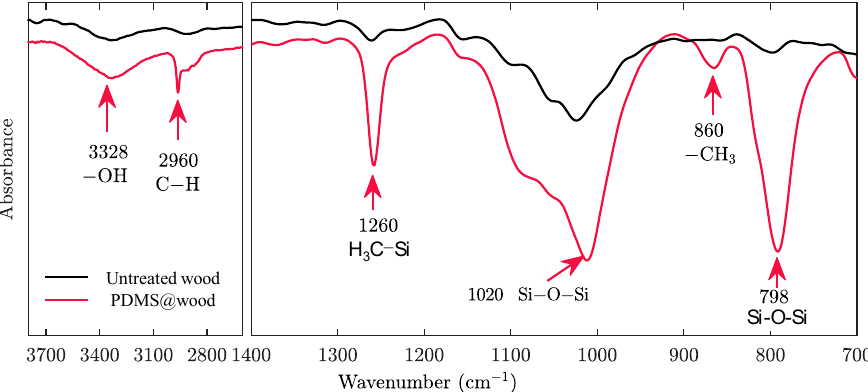
Figure 3. FT-IR spectra of untreated wood and PDMS@wood.